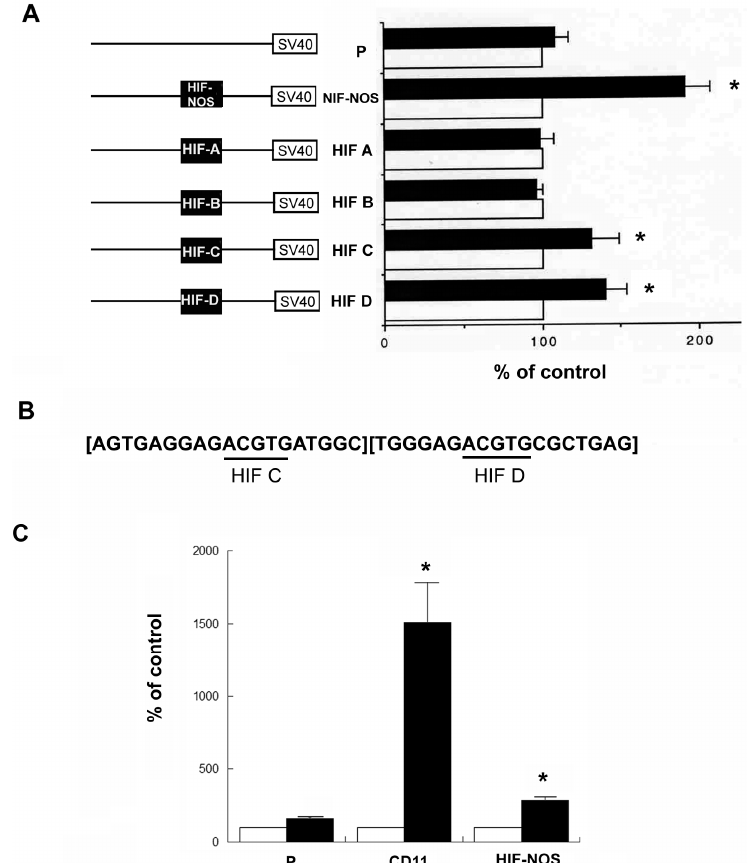
Figure 3. Identification of functional hypoxia inducible factor (HIF) response elements located at 5 ′ -upstream of the start codon of the hKOR gene under DFO treatment. ( A ) Based on the consensus sequence comparison, four potential HIF response elements located at the 5 ′ -upstream of the start codon of the hKOR gene were identified. These HIF response elements were individually cloned into the pGL3-promoter vector (P), containing SV40 promoter and the luciferase reporter gene. Resulting plasmids were designated as HIF A–D. A positive control, HIF-NOS plasmid containing the HIF response element of the NO synthetase gene [21], was included. All plasmids were subjected to DNA sequencing to validate correct sequences. Transient transfection was performed using NMB cells. The pCH110 plasmid, containing the β -galactosidase, was also transfected simultaneously, and its activity was used as the internal standard for normalization purpose. Twenty-four hours after transfection, cells were treated without or with DFO for an additional 24 h. Cells were then harvested and luciferase assays were performed. The promoter activity of each construct with no DFO treatment (as the control) was arbitrarily defined as 100% (white bars). The activity of each construct under DFO treatment (black bars) was presented as % of control activity. Histograms represent mean values of activation. Error bars indicate S.E.M. Experiments were repeated at least ten times. “*” indicates p < 0.01 (student t -test); ( B ) sequences of the combined HIF C (left side) and D (right side) elements are depicted. The HIF consensus sequences are underlined. There is an 11 bp spacing between the underlined HIF C and D elements; ( C ) NMB cells were transfected with the CD11 plasmid (containing both HIF C and D elements), the vector (pGL3-promoter), and the positive control (HIF-NOS), respectively. The pCH110 plasmid with β -galactosidase gene was also included as an internal standard for normalization. Twenty-four hours after transfection, cells were treated without (control; white bars) or with DFO for an additional 24 h (black bars). Cells were harvested and luciferase assays were performed. The promoter activity of each construct under DFO treatment (black bars) was expressed as % activity of the non-DFO treated control, arbitrarily defined as 100% (white bars). Histograms represent mean values of activation. Error bars indicate S.E.M. Experiments were repeated at least six times. “*” indicates p < 0.01 (Student t -test).